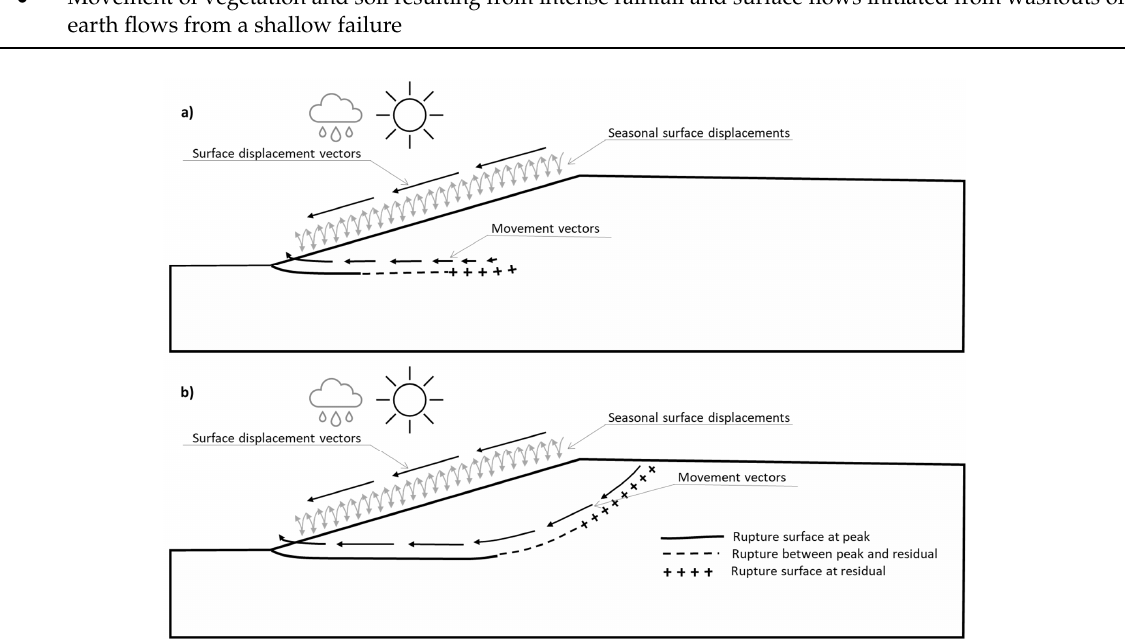
Figure 5. Embankment cross section showing the development of progressive failure mechanism, where ( a ) is the early development of a rupture surface at the toe of the slope, followed by ( b ) just before failure (modified after Network Rail [9]).